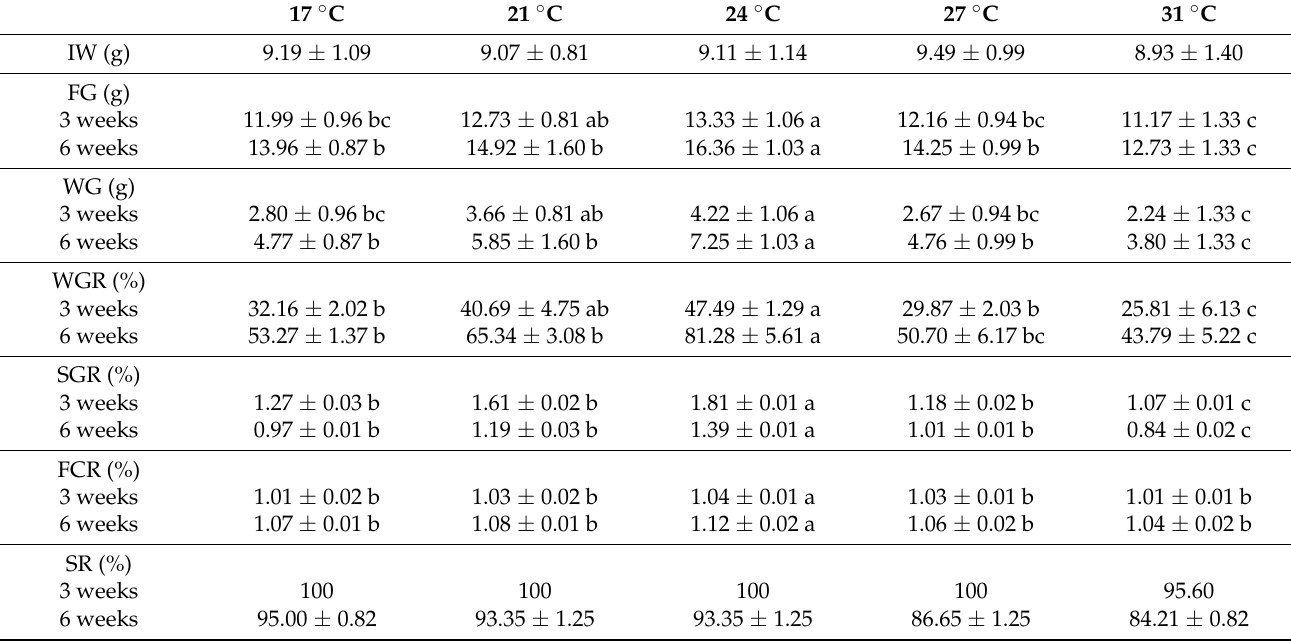
Table 2. Growth performance of crucian carp under five temperature